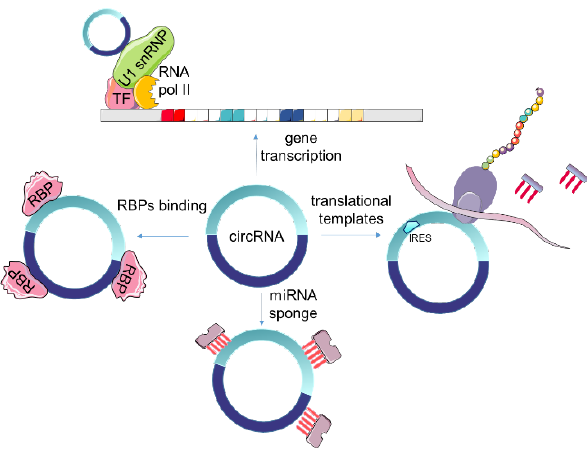
Figure 2. Functions of circRNAs.